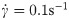
Fracture of 1mM T9-CR4-T9 composite hydrogels for a range of volume fractions of SiO2 nanoparticles.A: Storage modulus G’(ω) at ω = 6.28rad/s, as a function of strain γ for different fraction of SiO2 nanoparticles. Colors as in Fig 3A. B: The derivative ΔG′/Δγ measuring the change in modulus in the strain amplitude sweep. Note the logarthmic scale on the vertical axis. The peak position represents the strain at break, the full width at half the maximum (FWHM) the error bar on the peak location. Inset: strain-at-break as a function of volume fraction of SiO2 nanoparticles taken from the strain sweep of A. Colors and symbols as in Fig 3B. C: Stress τ versus strain γ at a constant shear rate of γ˙=0.1s-1. D: strain-at-break as obtained from the flow curves in C, which we take as the fracture point (solid symbols). Open symbols are the fracture points obtained from the strain sweeps and as reproduced from B. The vertical dashed line indicates the boundary between the one phase (1ϕ) and two phase (2ϕ) regions. E: the different bond rupture mechanisms for protein-protein (pp) bond rupturing, protein-silica (ps) rupture and phase-separation induced boundary-boundary (bb) rupture as referred to in panel A.